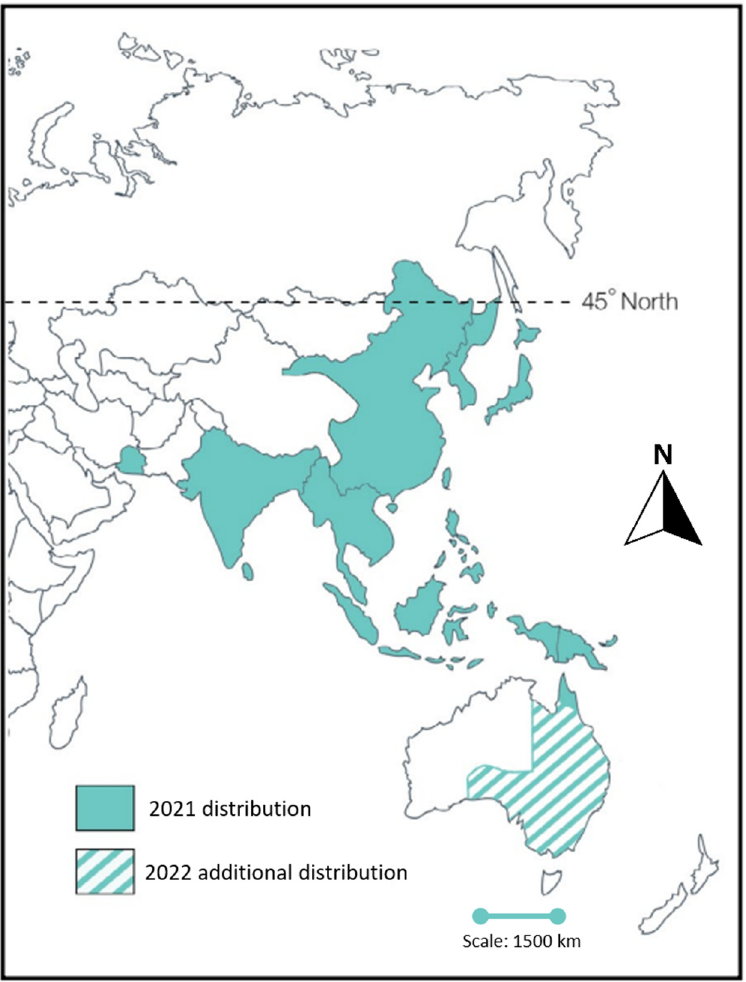
Figure 1. Japanese encephalitis virus is endemic throughout tropical and temperate areas of Asia, up to the 45th parallel. In Australia, local transmission prior to 2021 had been confined to the outer islands of the Torres Strait and Cape York, where it was first identified in 1995. As of May 2022, distribution may have expanded to include large parts of Queensland, New South Wales, Victoria and South Australia. This figure was adapted from the WHO under a creative commons license and is taken, with permissions, from the QIMR Berghofer